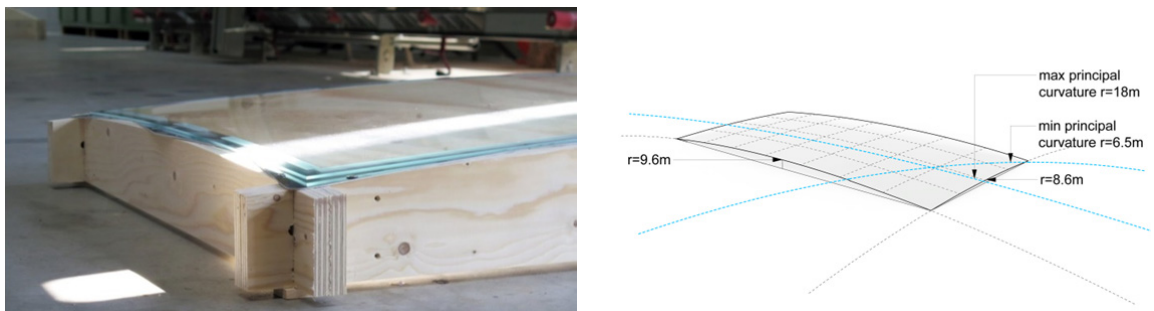
Fig. 8 First synclastic double-curvature prototype.